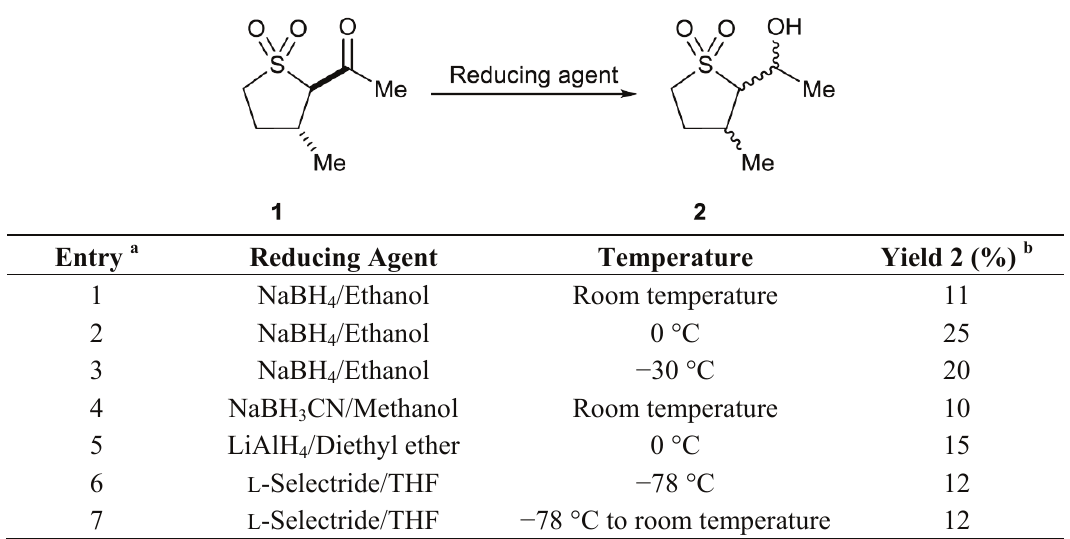
Table 1. Chemical reduction of trans -2-acetyl-3-methyl sulfolane 1